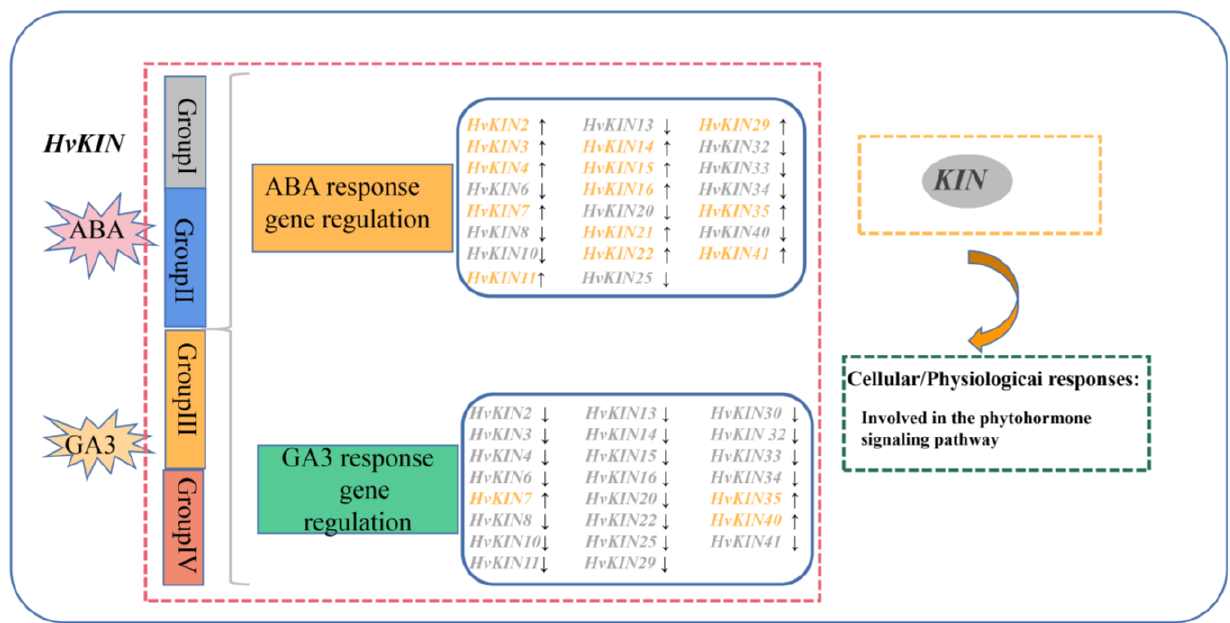
Figure 11. A model for summarizing the role of HvKINs based on gene expression profiles in barley.